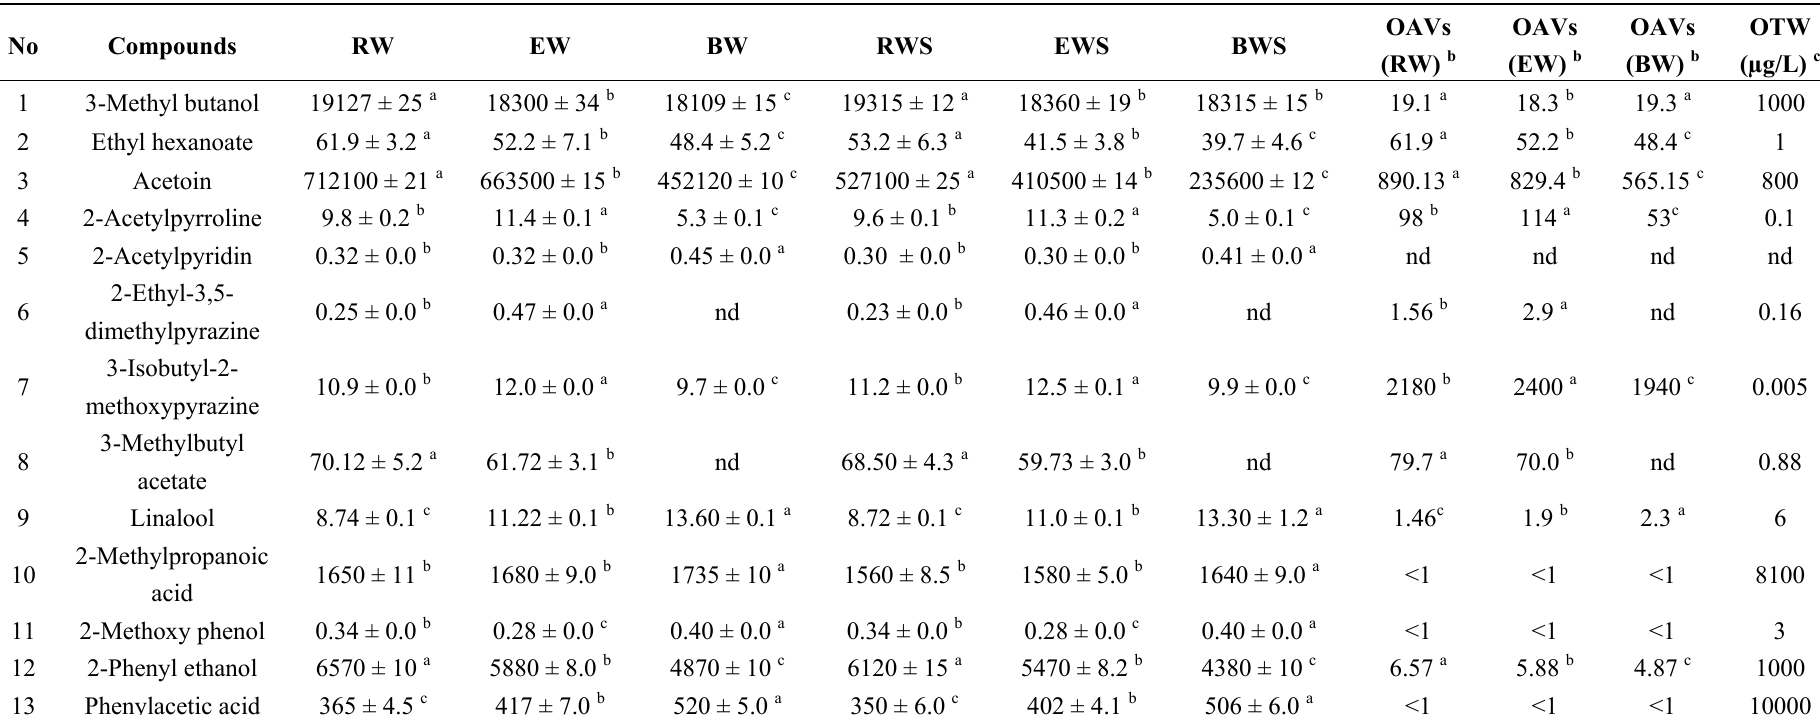
Table 2. Concentration of potent odorants in wines (RW, EW and BW) and wines + saliva (µg/L) a